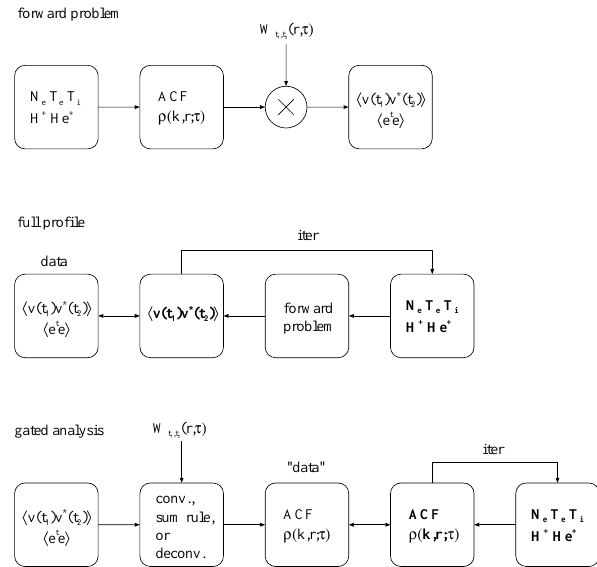
Fig. 1. Diagram comparing gated and full-profile analysis methods. Bold characters denote model parameter candidates (see